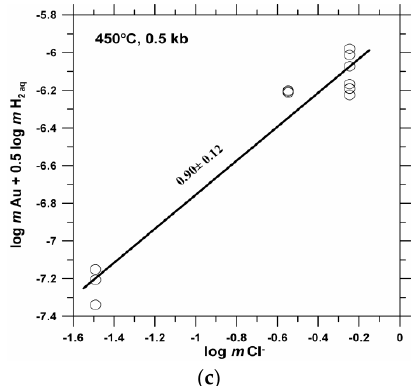
Figure 2. ( a ) The concentration of Au (corrected for Cl − concentration according to Equation (2)) as a function of H 2 ° (aq) concentration under reduced conditions. ( b ) The concentration of Au (corrected for Cl − concentration) as a function of H 2 ° (aq) concentration under reduced to oxidized conditions. ( c ) The concentration of Au (corrected for the of H 2 ° (aq) concentration) as a function of Cl − concentration under reduced conditions.